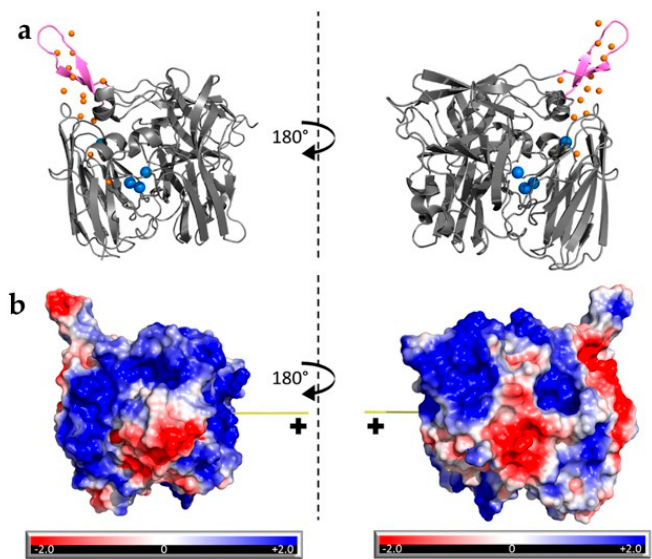
Figure 7. ( a ) Model structure of Tt Lac (PDB 2XU9) showing the hairpin domain (magenta), the T 1 and T 2 / T 3 Cu centers (blue spheres) and all Met sulfurs (yellow spheres); ( b ) Electrostatic potentials at the surface of Tt Lac in the same orientation as in the top panel at pH 5: positive charges in blue, negative charges in red, and neutral in white. The positive end of the dipole moment vector is shown as a yellow stick. Reproduced with permission from [69]. Copyright 2020, American Chemical Society.